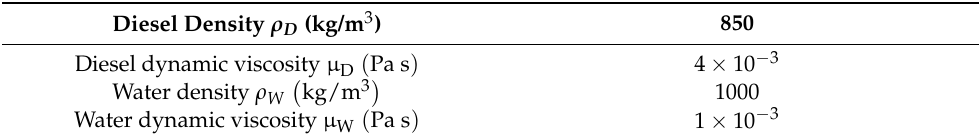
Table 5. Transport properties of water and diesel.